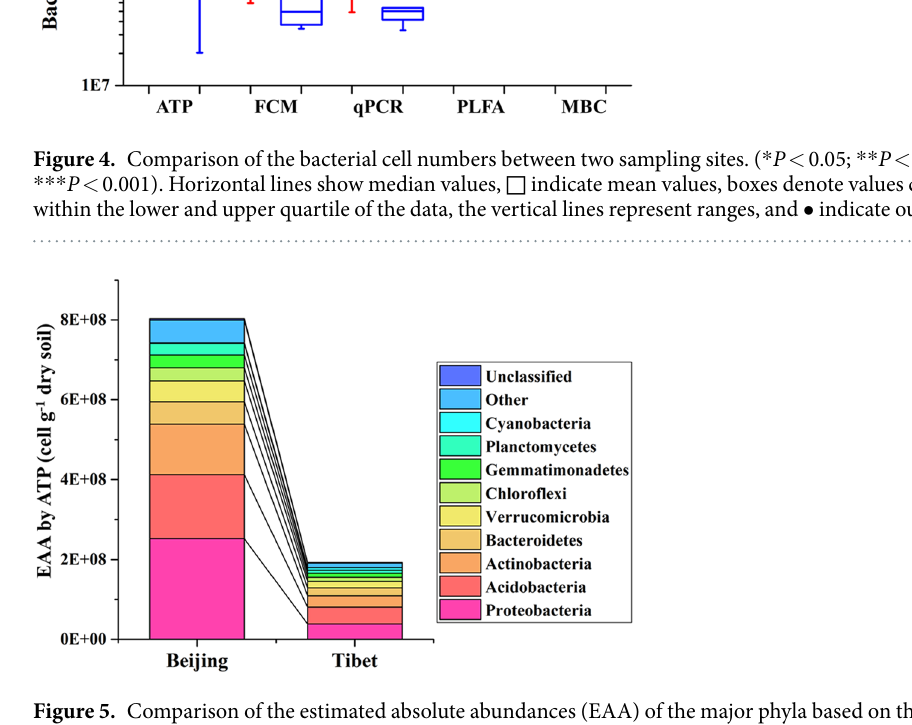
Figure 5. Comparison of the estimated absolute abundances (EAA) of the major phyla based on the ATP measurement in the two sampling sites. ATP: adenosine